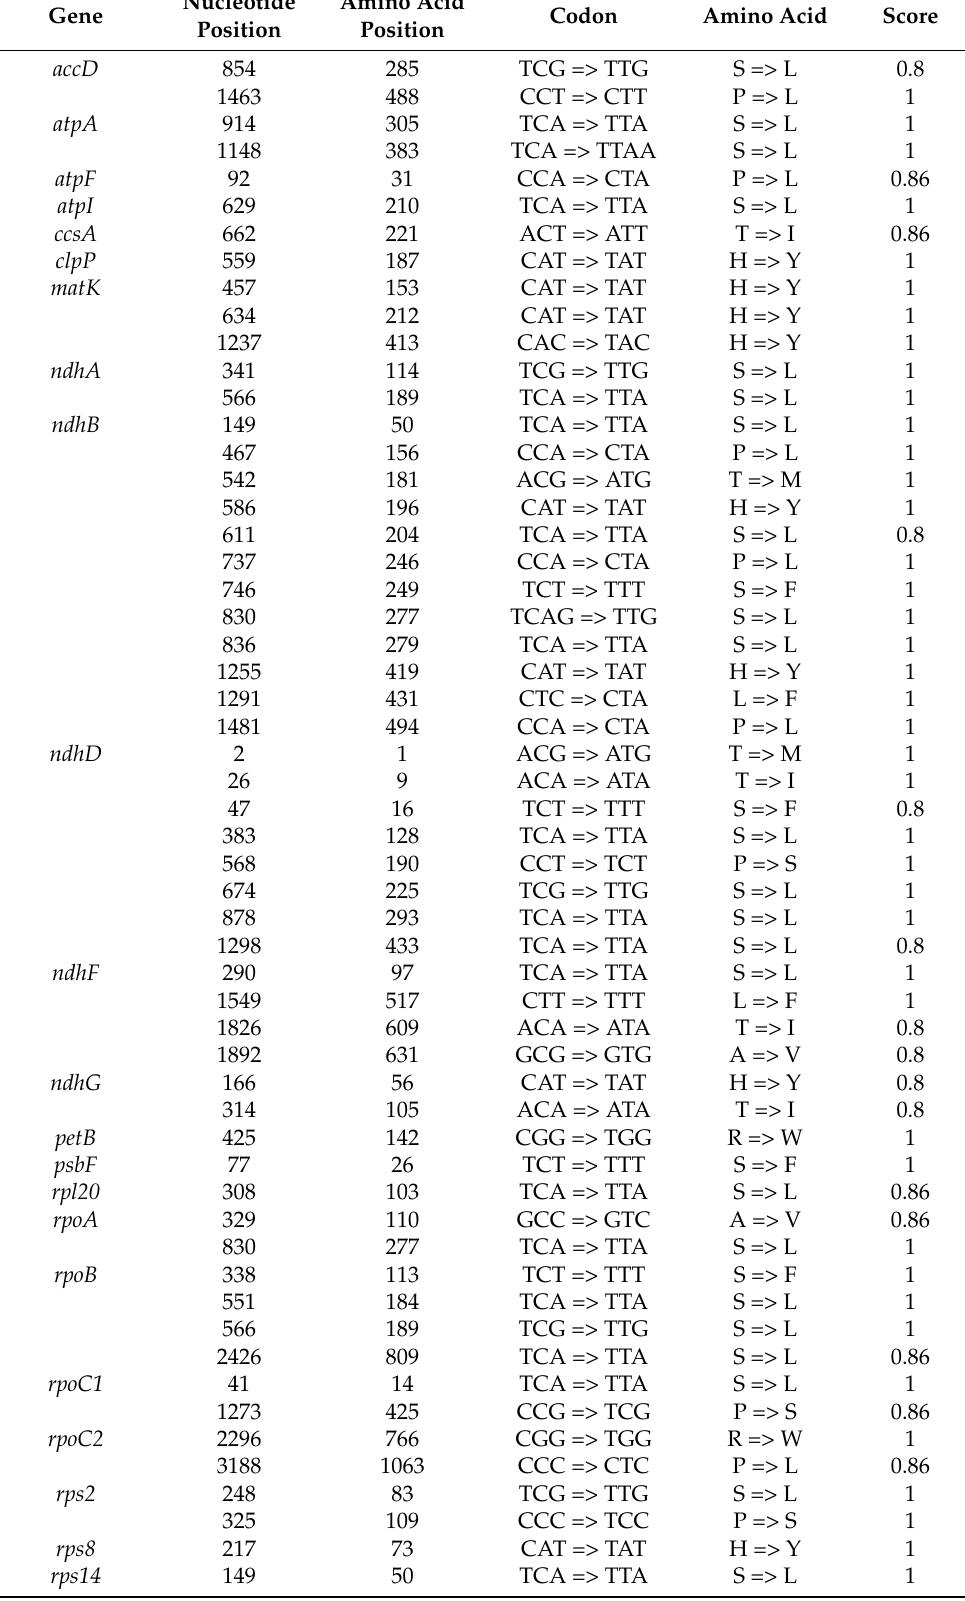
Table 5. Predicted RNA editing sites in the A. fruticosum chloroplast